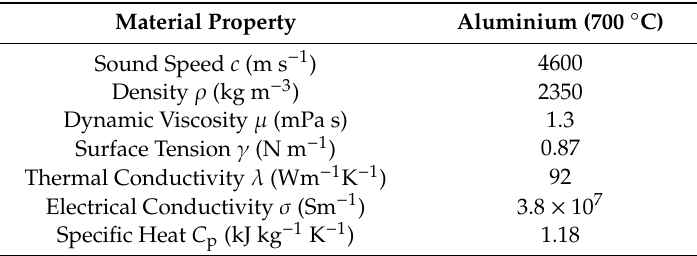
Figure 2. Predicted induced stirring and Joule heating in a typical aluminium crucible interacting with a descending conical coil. The main furnace coil operating at 2.4 kHz is switched of when the coil is in the lowest position, to maintain a maximum temperature of ~700 °C. Indicated temperature contour range < 699–702 °C. Maximum induced velocity is ~0.7 m/s. Table 1. Material properties of aluminium.